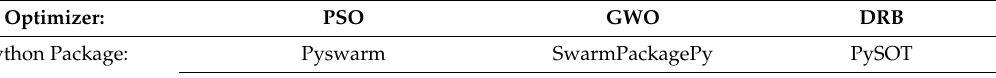
Table 1. The three global optimizers, their respective Python packages, common inputs needed and additional inputs. PSO: Particle Swarm Optimization; GWO: Gray Wolf Optimization; DRB: DYCORS / radial basis function.